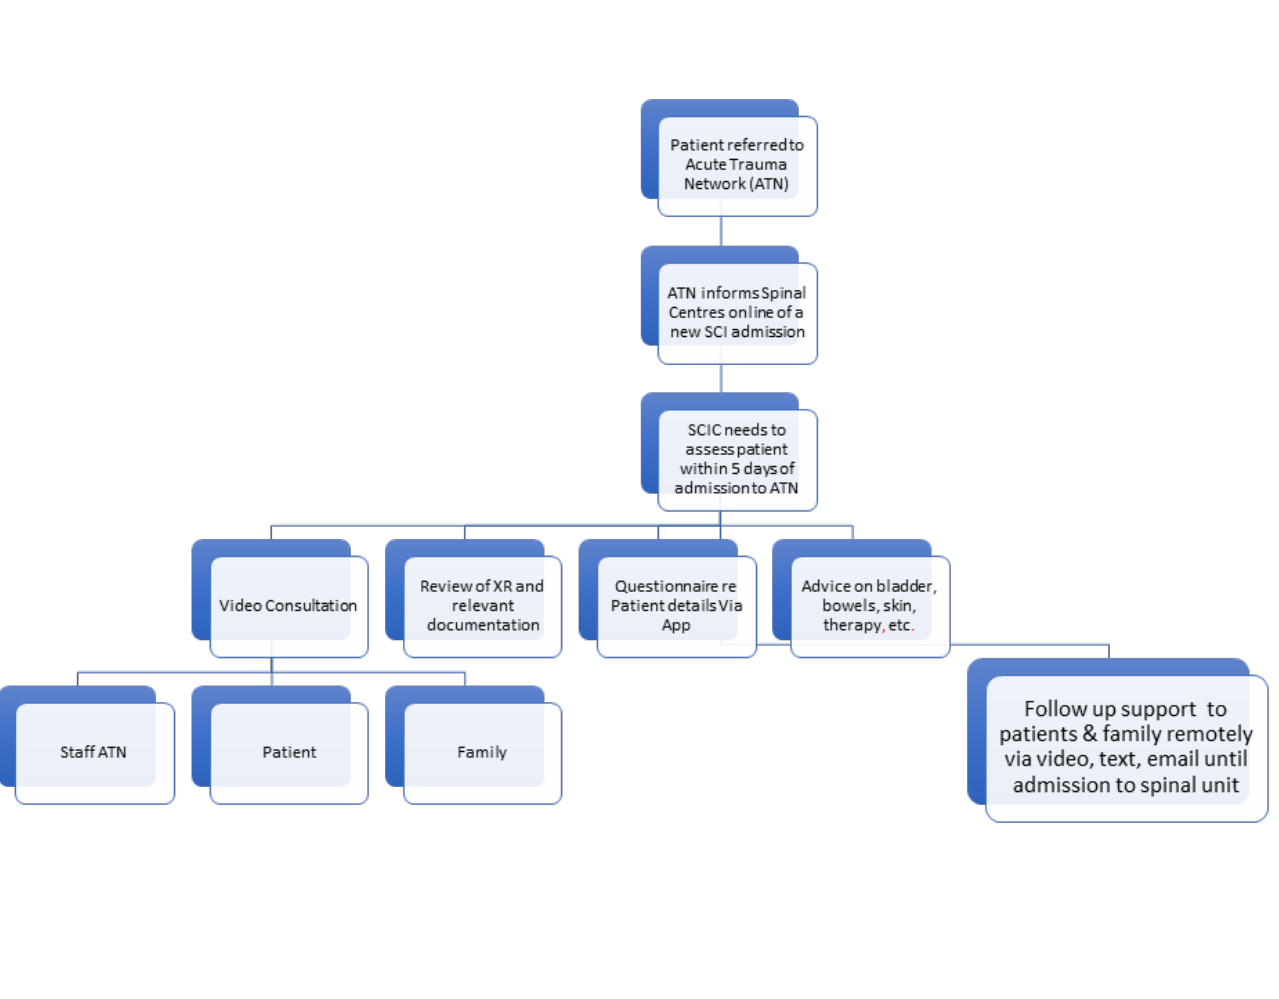
Figure 4. Use of technology for acute spinal cord injury (SCI)